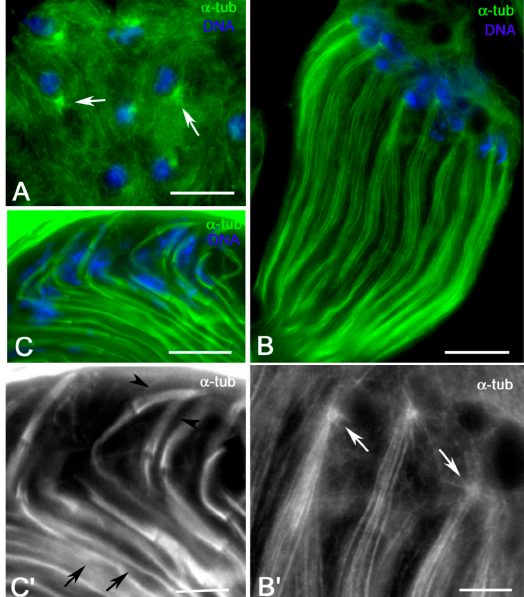
Figure 2. Microtubule (MT) distribution in early elongating spermatids obtained from dissected testes. ( A ) Onion stage spermatids: note the small MT asters close to the nuclei (arrows). ( B , B’ ) Early elongating spermatids showing bundles of parallel MTs that originate from the small asters close to the nuclei (arrows). ( C , C’ ) Leaf stage spermatids, in which tail MTs compacted (arrows) and the perinuclear MTs cluster at one side of the nucleus (arrowheads). Scale bars: ( A – C ), 10 µ m; ( B’ , C’ ), 5 µ